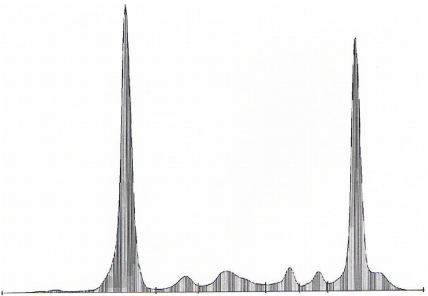
Figure 4: The serum protein electrophoresis graph that remained unchanged during the course of the